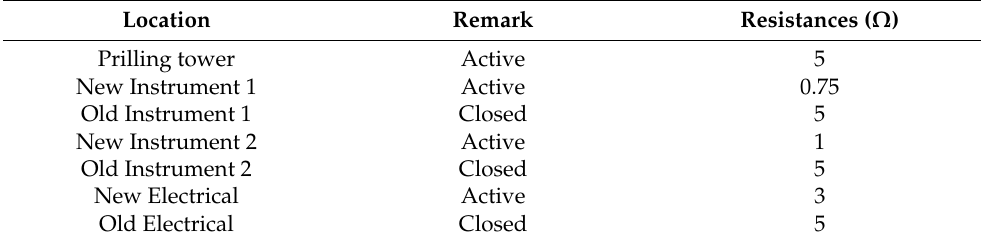
Table 3. Measured ground